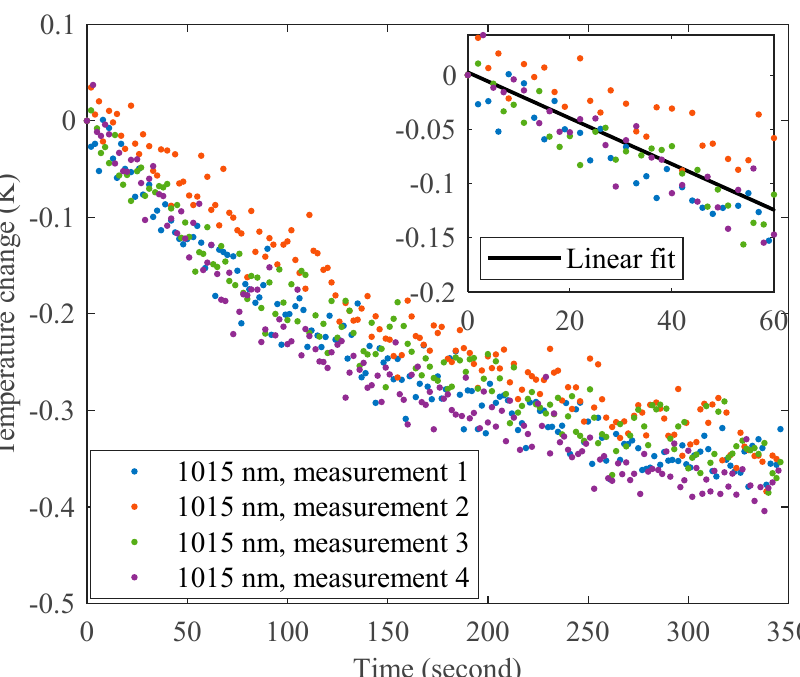
Figure 8. Temperature vs time after the cooling beam is introduced into the Yb:YLF sample. Data were obtained by the DLT method with pump power of 0.8 W at λ = 1015 nm. At this wavelength, the sample cools. A linear fit to the temperature change during the first minute had a slope of − 2.11 × 10 − 3 K/s (inset).